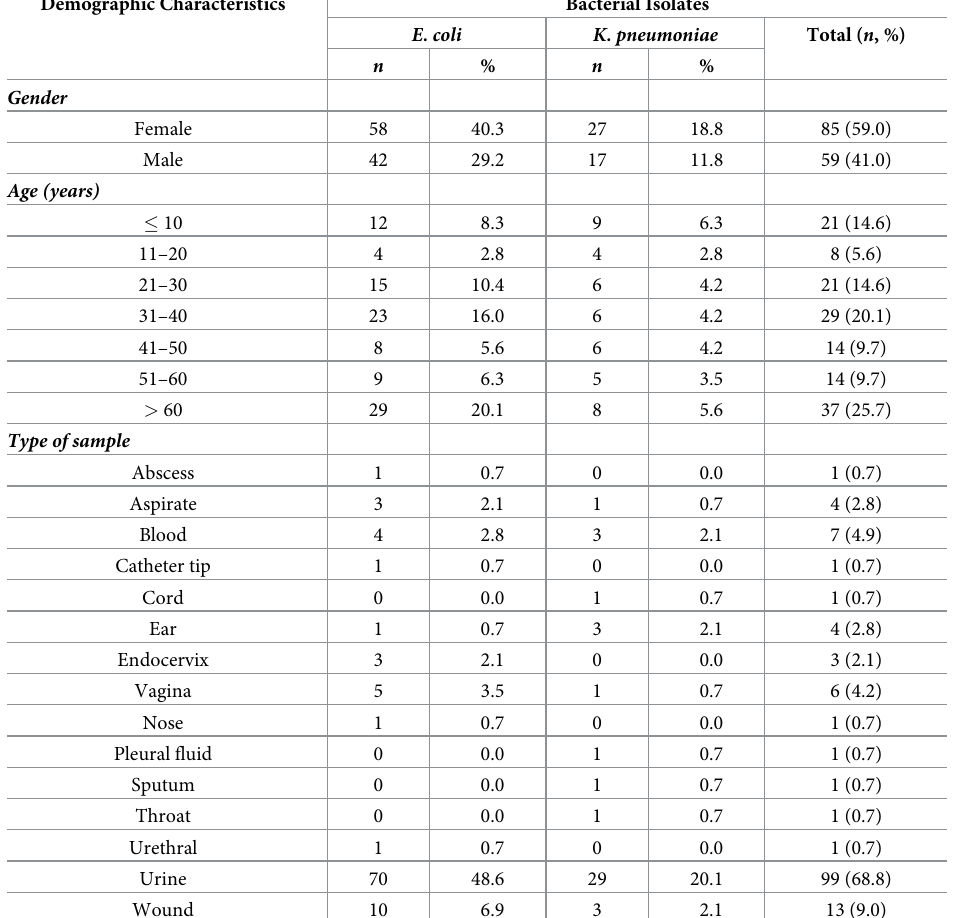
Table 2. Distribution of bacterial isolates by gender, age, and sources of sample collection.